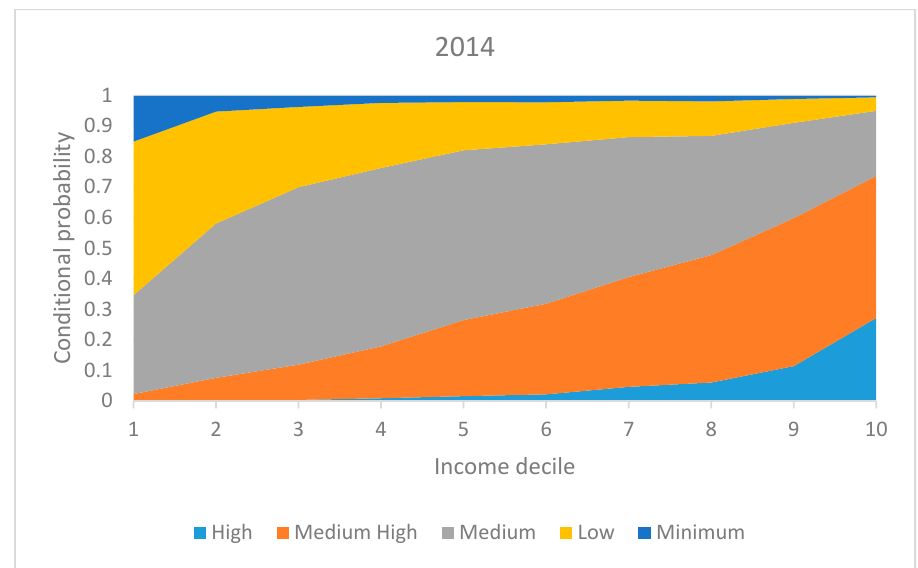
Figure 10. Conditional probabilities for consumer practices latent class membership over income deciles. Mexico 1992 and 2014. Source: Authors’ calculations, ENIGH (1992–2014).